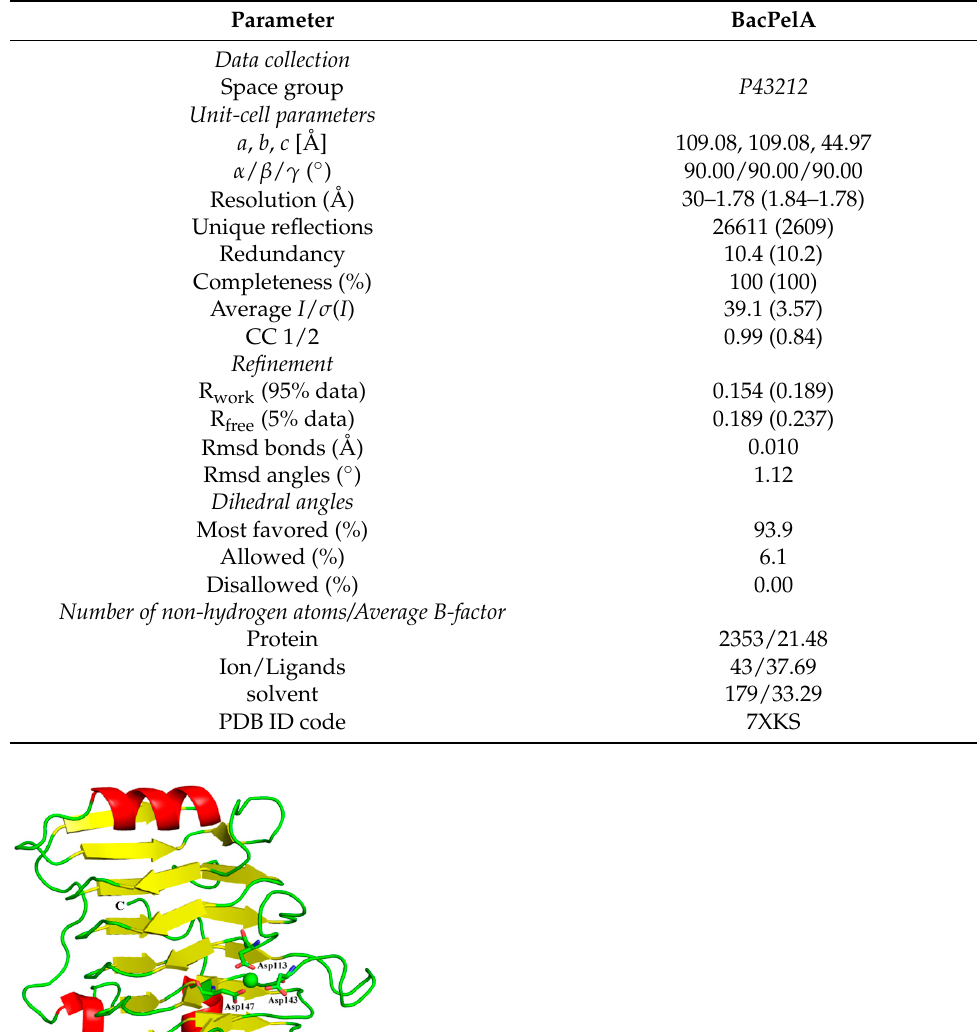
Table 1. Summary of X-ray data collections and refinement statistics.